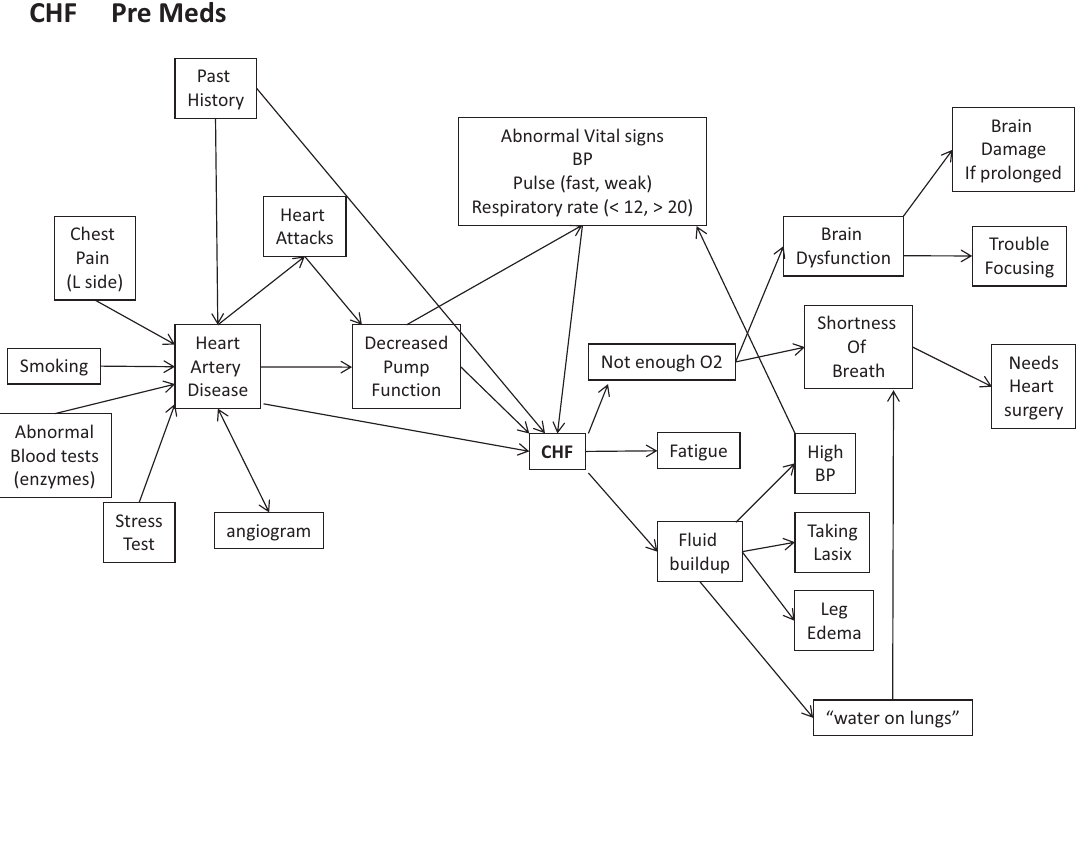
Figure A1. Premedical